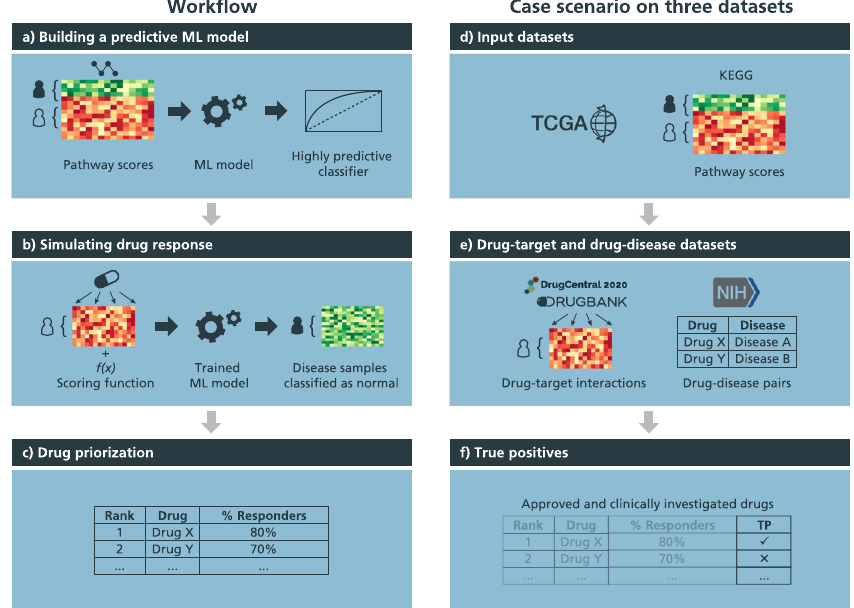
Fig. 1 Conceptual overview of the drug simulation work fl ow and case scenario on multiple datasets. ( a ) Pathway activity scores are used to train a highly predictive ML model that differentiates between normal and disease samples, labeled green and red on the heatmap, respectively. ( b ) Next, pathway scores of disease samples are modi fi ed by using drug-target information and applying a scoring algorithm that simulates the effect of a given drug at the pathway-level. Using the modi fi ed pathway scores of disease samples, the trained ML classi fi er is then used to evaluate whether these modi fi ed disease samples that were previously classi fi ed as “ diseased ” could now be classi fi ed as “ normal ” . ( c ) Finally, we use the proportion of disease samples now classi fi ed as normal (i.e., % responders) as a proxy to identify candidate drugs and propose combination therapies. ( d ) To demonstrate the methodology in a case scenario, we fi rst performed ssGSEA using pathways from KEGG and the BRCA, LIHC, PRAD, and KIRC TCGA datasets to acquire sample-wise pathway activity scores. ( e ) Next, we obtained known drug-target interactions from DrugBank and DrugCentral and drug-disease pairs (i.e., FDA-approved drugs and drugs under clinical trials for a given condition) from Clinicaltrials.gov and FDA-approved drugs, of which, the latter two were used as a ground-truth list of true positives (TP). ( f ) To simulate drug treatments of patients from the aforementioned TCGA datasets using their pathway activity scores (i.e., Fig. 1d), we applied the methodology described in Fig. 1a – c to acquire a ranking of drugs based on the proportion of disease samples that were treated. Finally, we identi fi ed the proportion of drugs ranked by our methodology that were true positives for the four TCGA datasets and compared this proportion to random